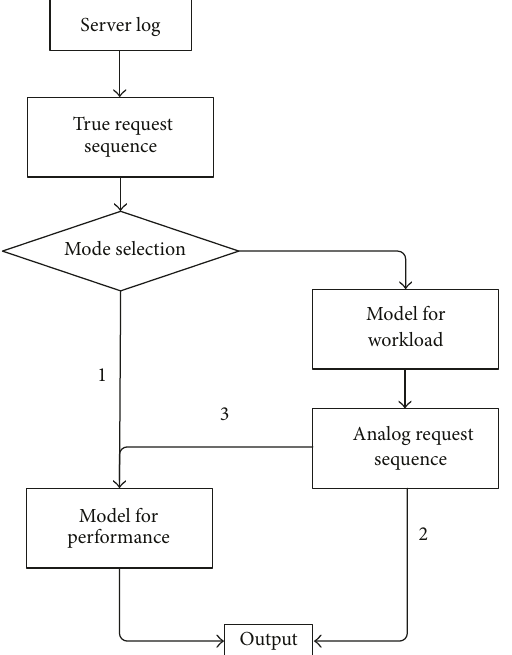
Figure 4: Application framework for two